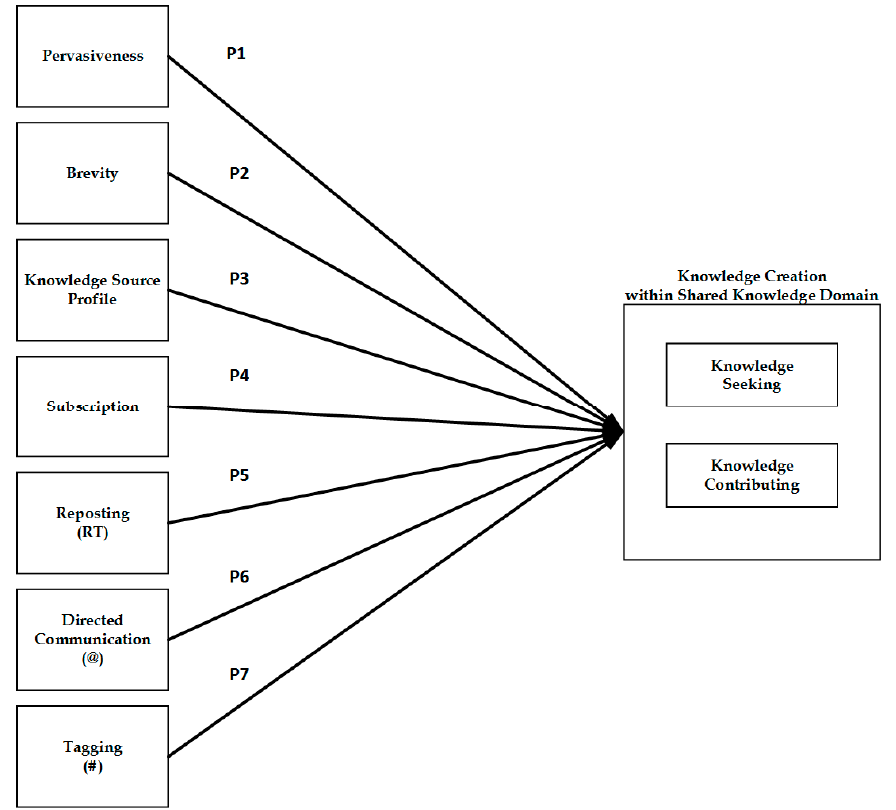
Figure 2. Proposed model for microblogging corporate knowledge creation within shared knowledge domain. Figure